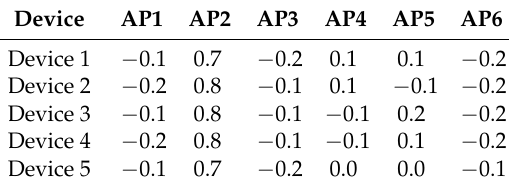
Table 2. Processed results of Table